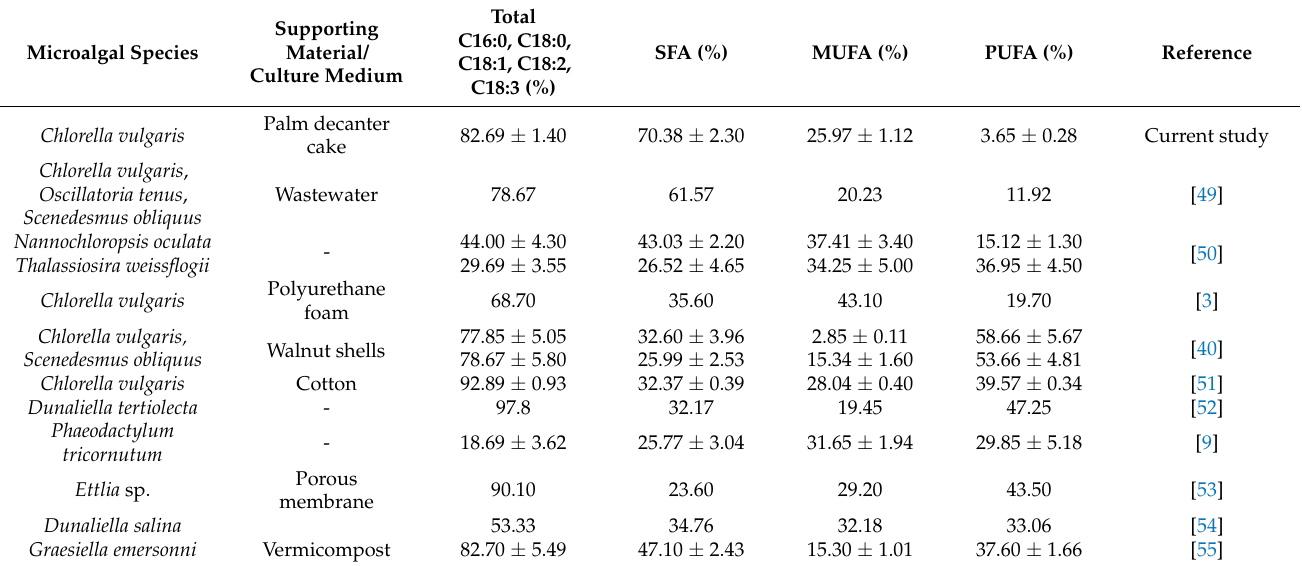
Table 5. FAME contents derived from various microalgal strains grown on various supporting materials and growth